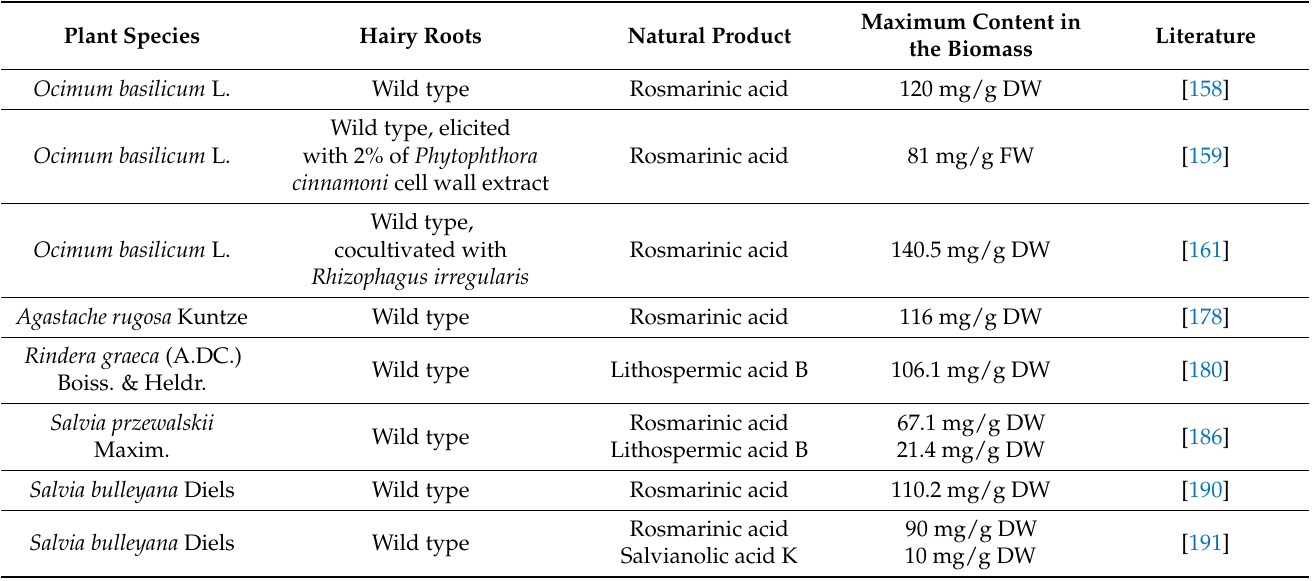
Table 5. Hairy root cultures that produced high yields of polyphenolic antioxidants (RA, lithospermic acid B, and salvianolic acid